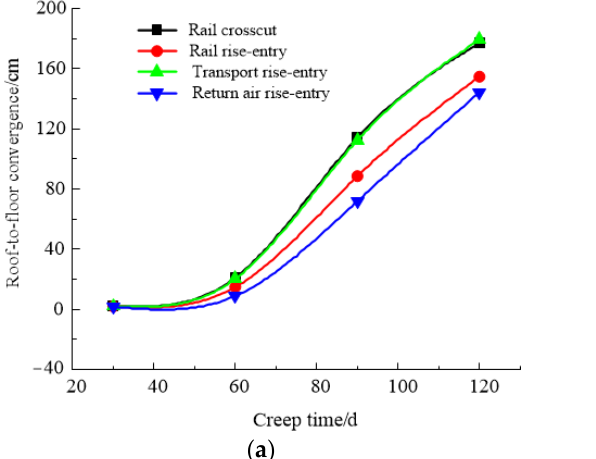
Figure 16. Monitoring results of convergence in roadway-concentrated areas under different creep time conditions. ( a ) Roof-to-floor convergence, ( b ) Two-sided convergence.